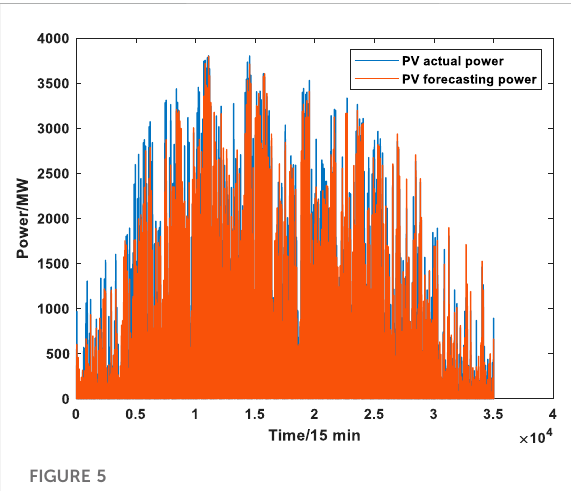
FIGURE 5 Actual power vs forecasting power of PV power